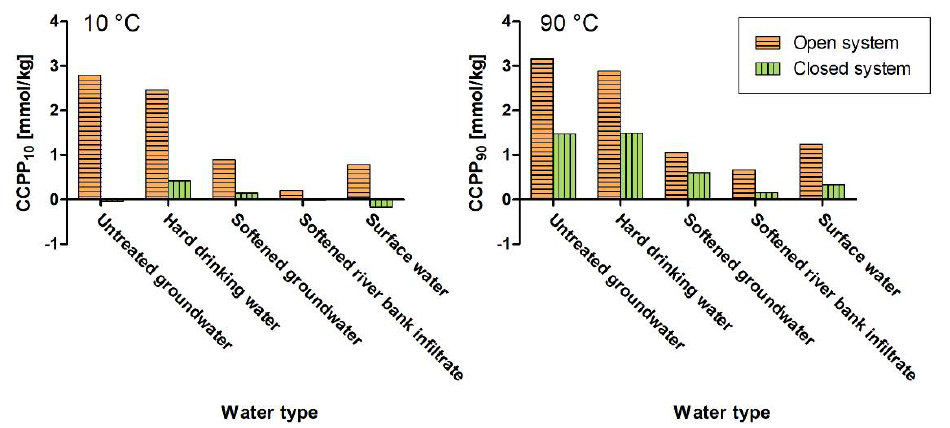
Figure 2. CCPP calculated for closed and open systems at 10 and 90 ◦ C for five water types. Untreated groundwater: Frederiksberg. Hard drinking water: Thorsbro. Softened drinking water: Brøndbyvester. Softened riverbank infiltration: Lekkerkerk. Surface water: